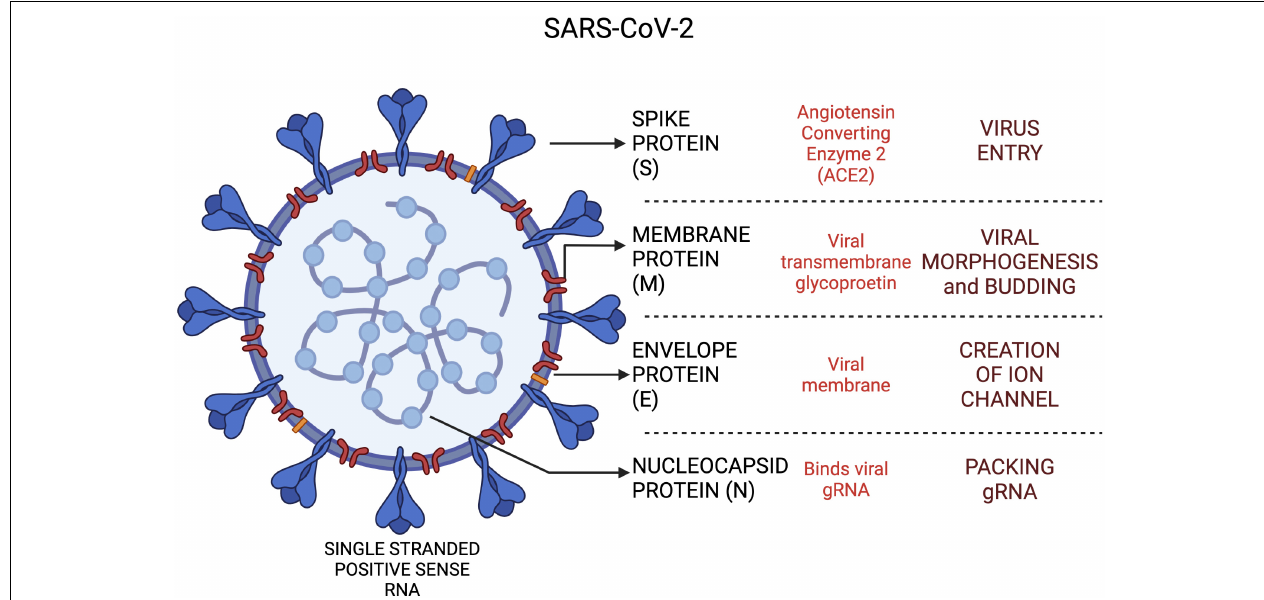
FIGURE 3 | The SARS-CoV-2 viral proteins and functional roles in host cells. Created with BioRender.com.